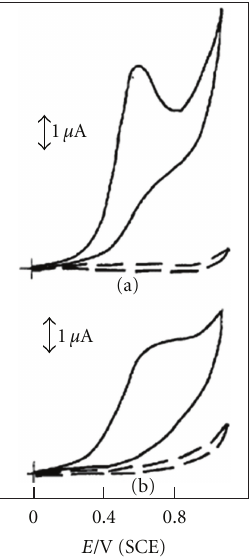
Figure 6: Cyclic voltammograms recorded in 0.5 M KHCO 3 containing 1 mM CySH: initial potential, 0.0 V (SCE); sweep rate, 5mVs − 1 . (a) BDD electrode; (b) GC electrode. (Dashed lines represent background curret.)